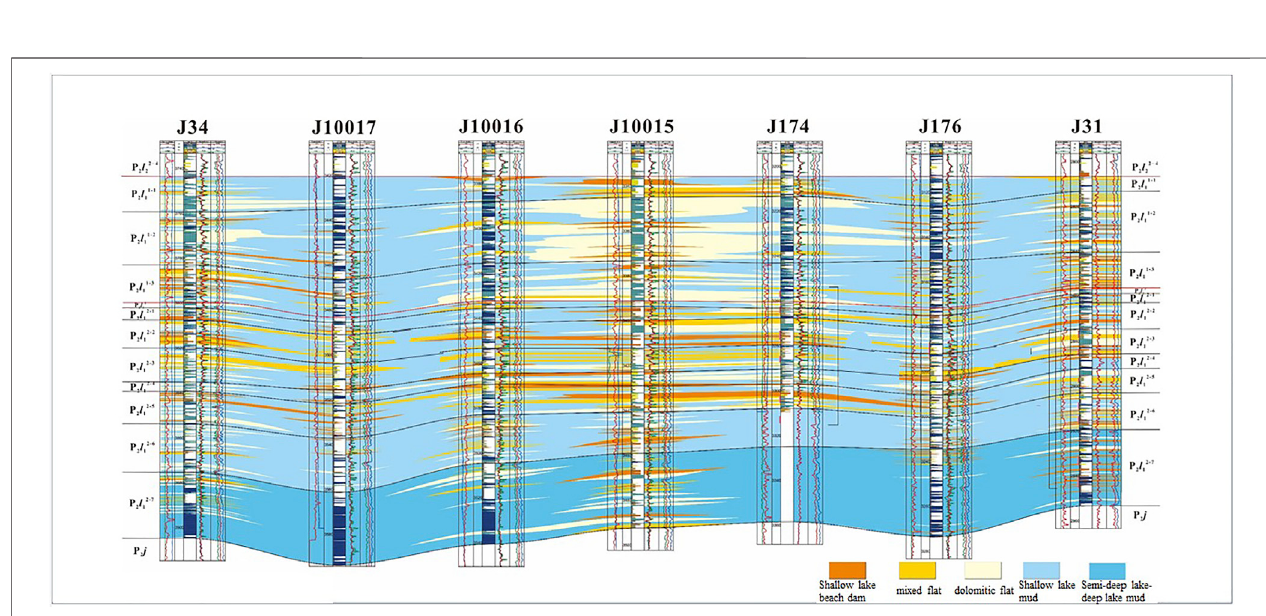
FIGURE 7 | Pro fi le facies of J34~J10017~J10016~J10015~J174~J76~J31 wells in the lower sweet spots of the Lucaogou Formation in the Jimsar Sag.